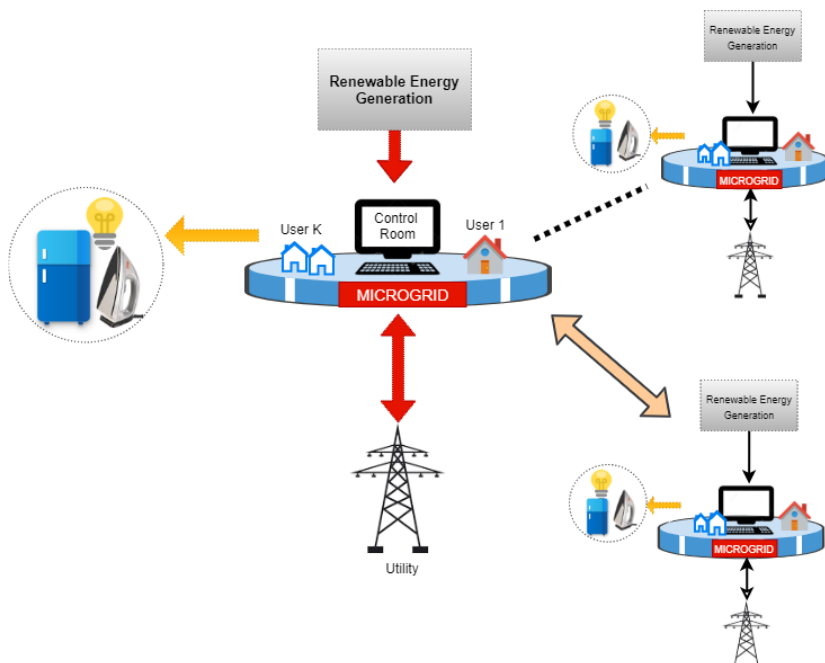
Figure 9. System model for scenarios 3 and